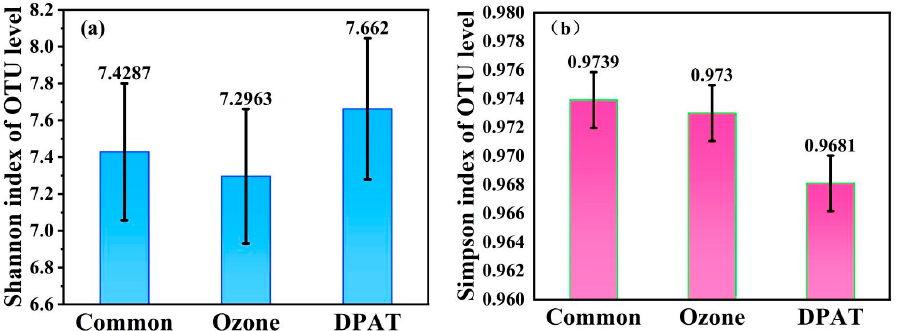
Figure 6. Alpha diversity of activated sludge samples evaluated by the Shannon index ( a ) and the Simpson index ( b ).